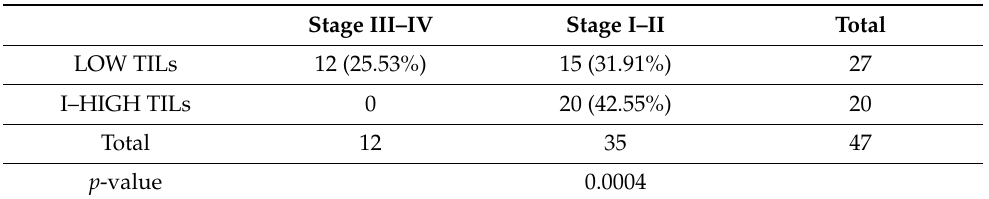
Table 2. Relation between TILs and stage.